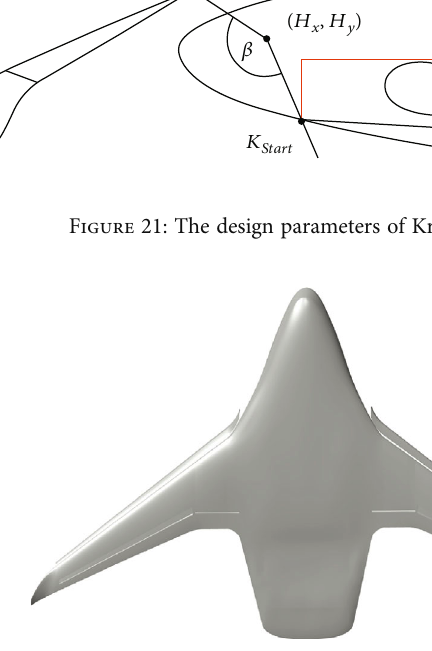
Figure 22: The shape of SWB-2 with high-lift device.